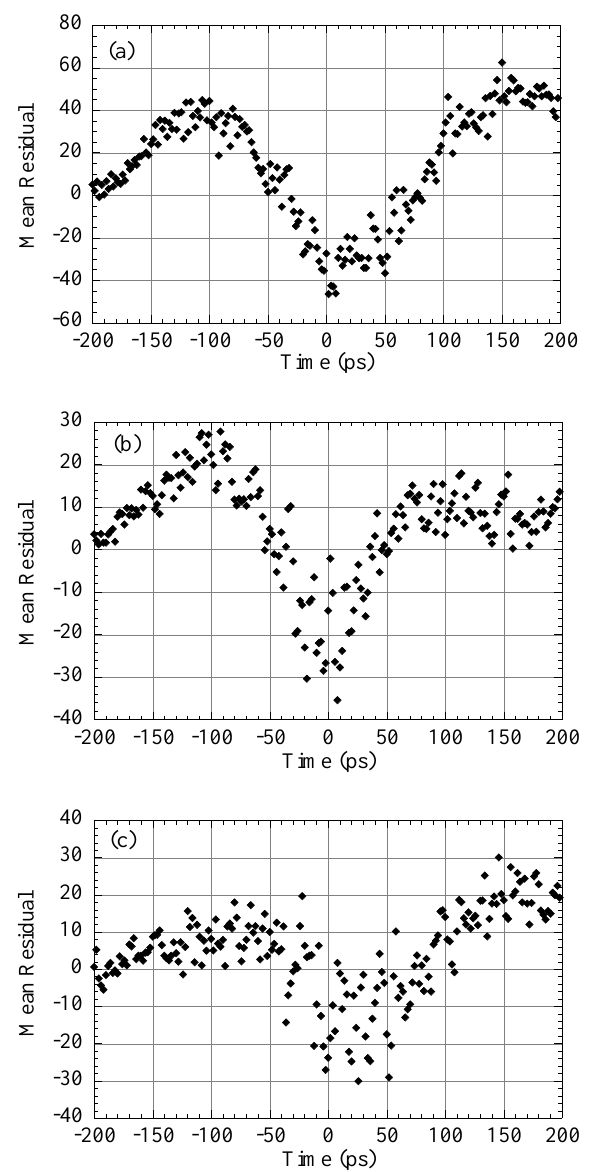
FIG. 25. The mean residual when the total current was between (a) 210–205 mA, (b) 195–188 mA, and (c) 175– 171